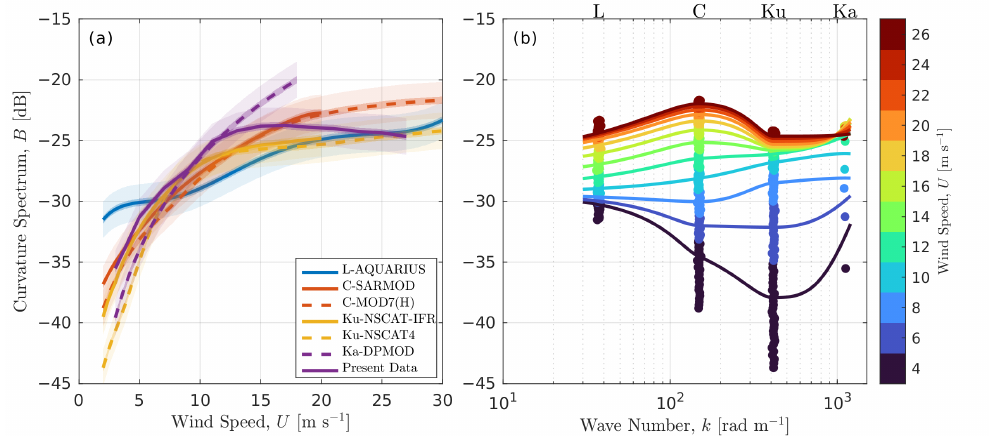
Figure 9. Folded curvature spectrum, B = ( B 0 ( k ) + B 0 ( − k )) /2, estimated for upwind direction from radar GMFs and our present data versus wind speed and wave number. Spectrum estimate uncertainty is shown by transparent shading in ( a ) wind speed; ( b ) wave